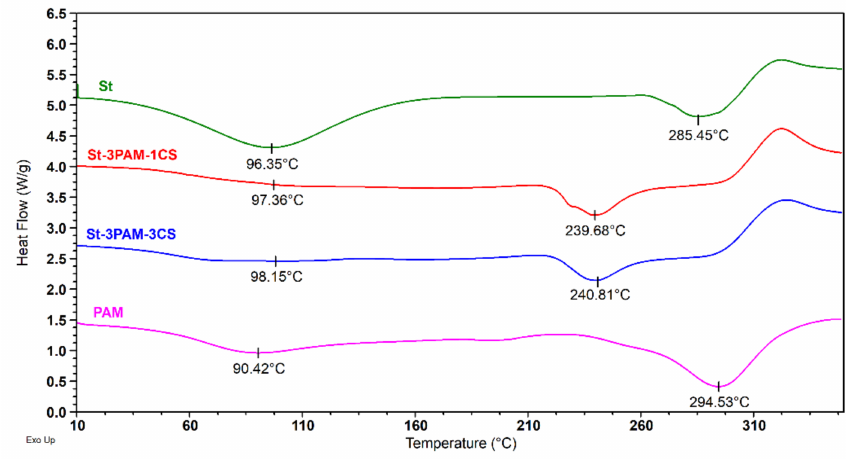
Figure 4. Differential scanning calorimetry (DSC) thermographs for native potato starch (St), poly- acrylamide (PAM), and starch grafted polyacrylamide hybrids with 1 wt.% of CSs (St-3PAM-1CS) or 3 wt.% of CSs (St-3PAM-3CS) and the St:AM molar ratio of 1:3.